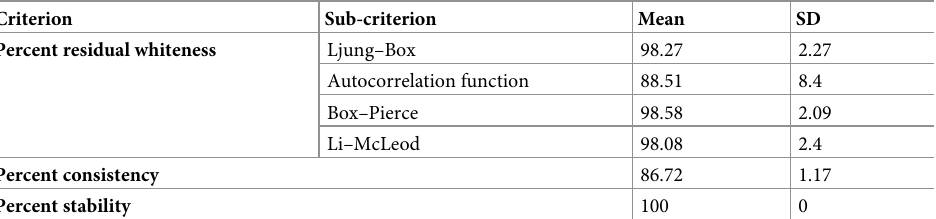
Table 1. Validation parameters of fitted models based on percent residual whiteness, percent consistency, and percent stability indices under standard-target and target-target conditions for 23